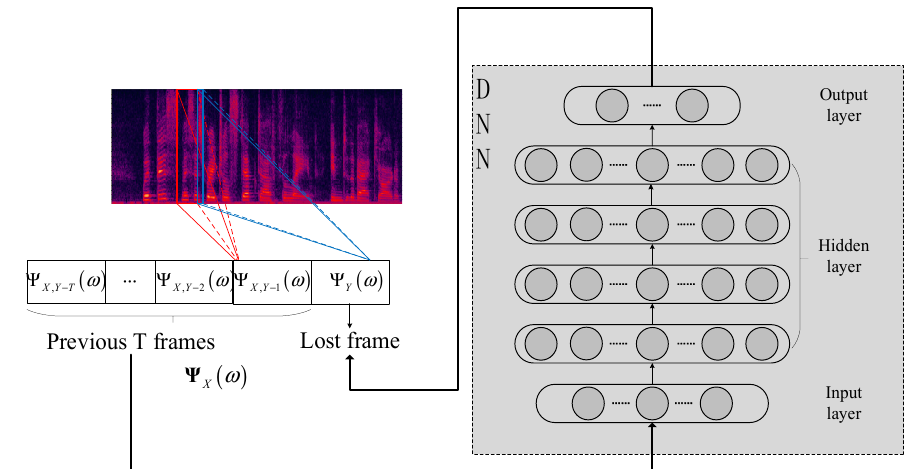
Figure 4. Amplitude spectrum prediction by DNN.